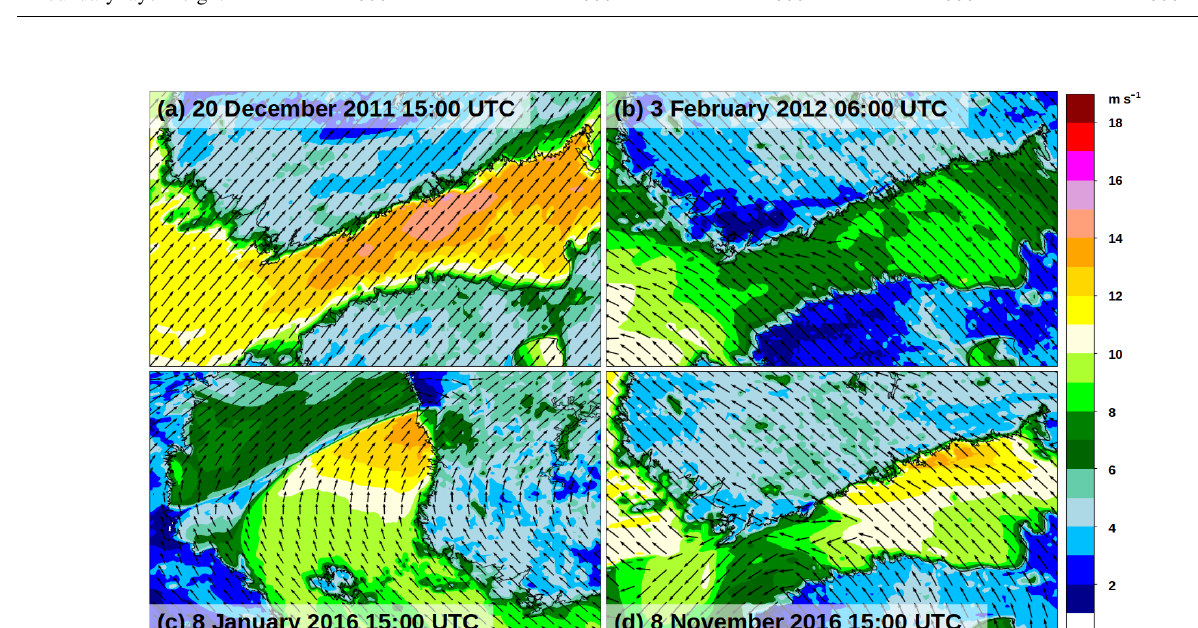
Figure A1. 10m wind speed (colors) and 900hPa wind direction (arrows) during the selected snow band cases, A–D, when the snowfall was over land areas as simulated with HARMONIE-AROME. The wind arrows are normalized to same lengths. (a) , (b) and (d) observes southern Finland and (c) observes western